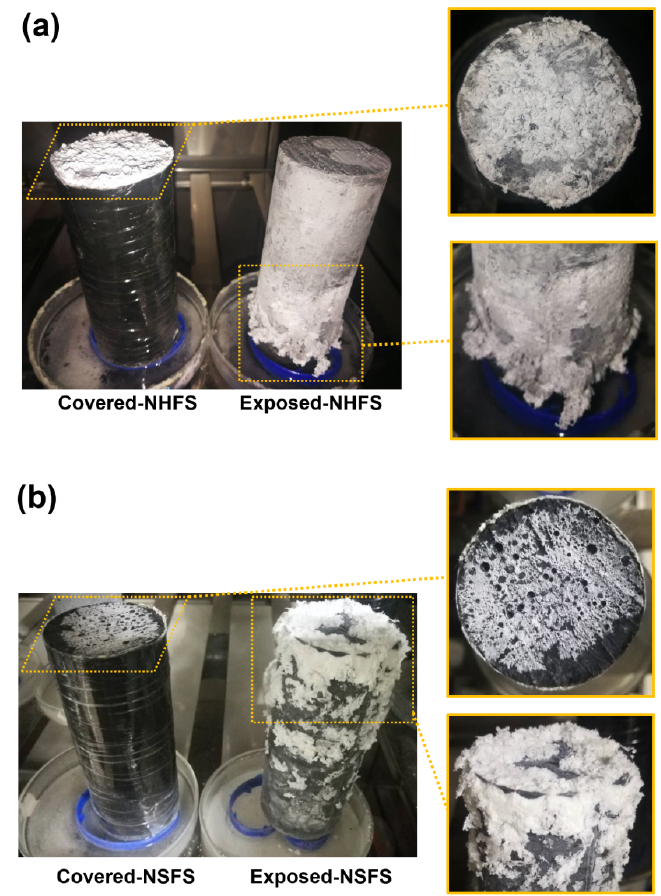
Figure 4. E ffl orescence of covered and exposed geopolymer cylinders: ( a ) prepared with NaOH (NHFS) and ( b ) sodium silicate activators